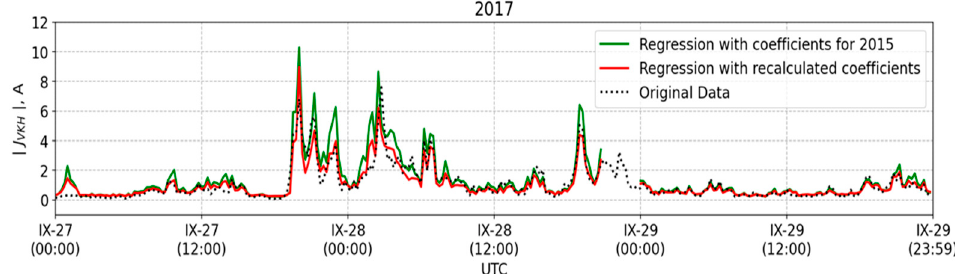
Figure 5. Estimation of the GIC level | J VKH | for 27–28 September 2017 (Kp = 7) event based on expression (6) with regression coefficients for 2015 (green line) and with coefficients recalculated for the period under consideration (red line). The values of the time series are averaged over 15 min intervals.